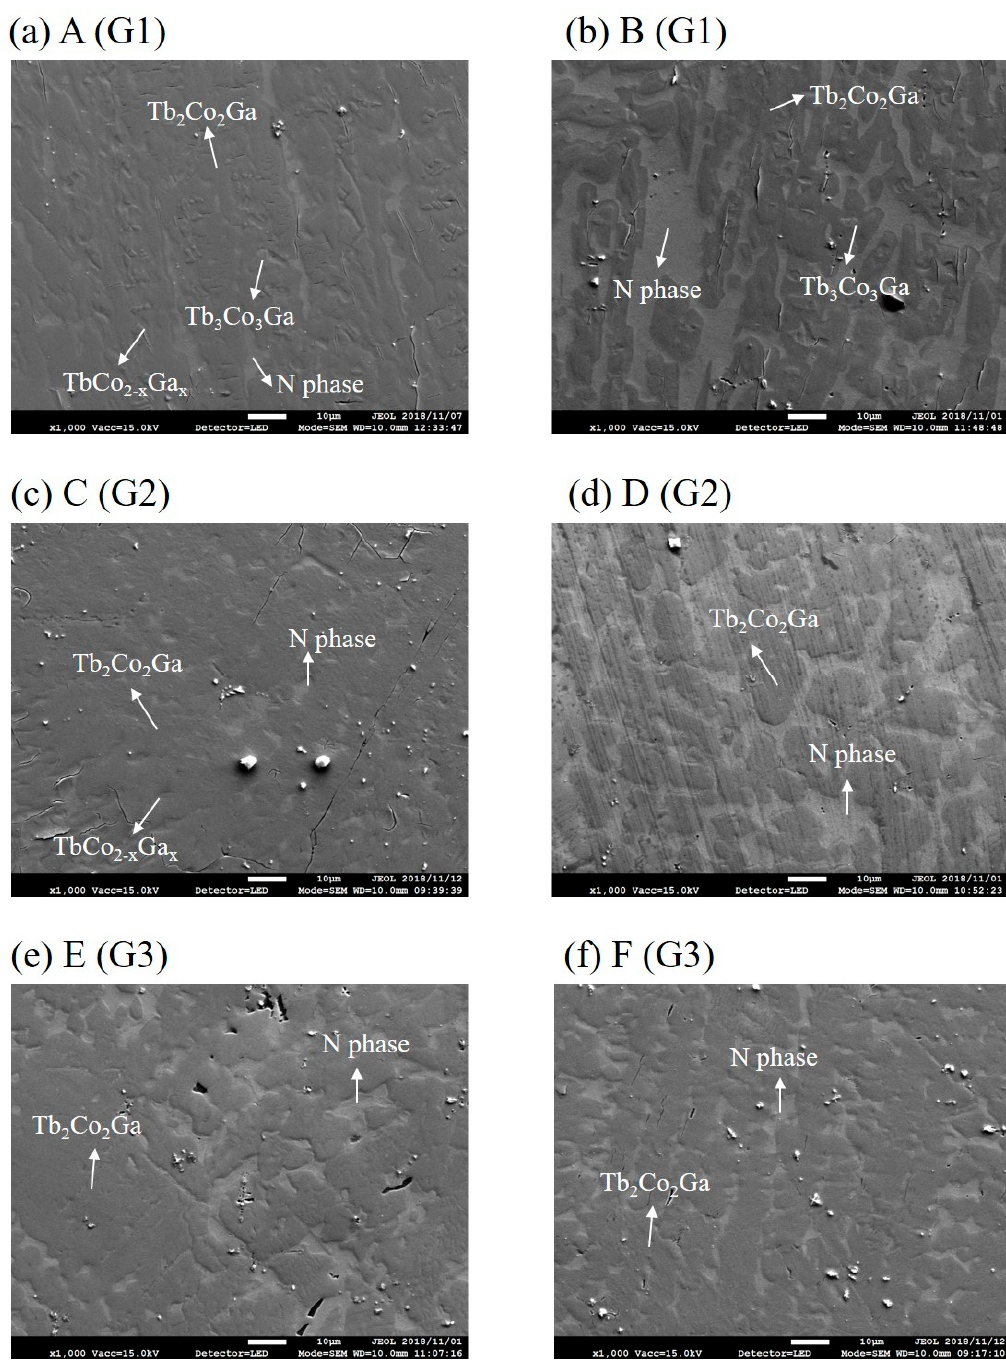
Figure 4. Back-scattered electron (15 keV) images of samples ( a ) A, ( b ) B, ( c ) C, ( d ) D, ( e ) E, and ( f ) F, respectively.